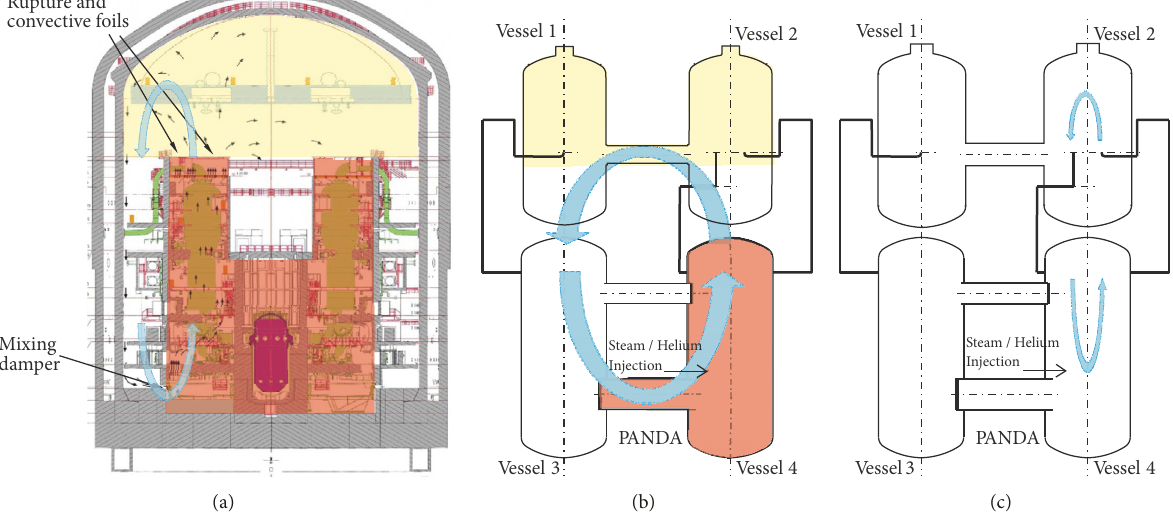
Figure 1: Two-room containment concept as implemented in an EPR (cid:2) (a) with prevailing convection loop and corresponding configuration of the PANDA facility (b) during the final state of the experiment HP6 1 and natural circulation loop for the KONVOI type containment (c) for experiment HP6 2. Corresponding areas have the same color. Picture on the left taken from Dimmelmeier et al.